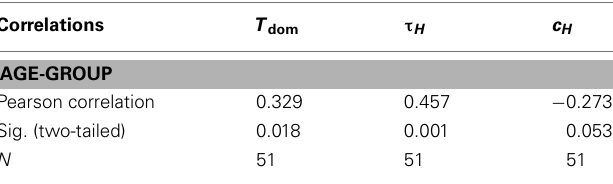
Table 1 | Correlations between age-groups and the investigated